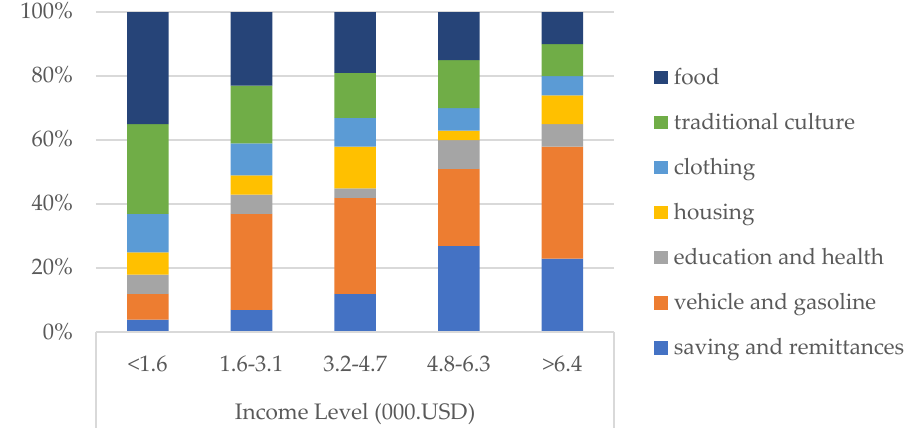
Figure 4. Types and proportions of expenditure at various income levels of landowners.